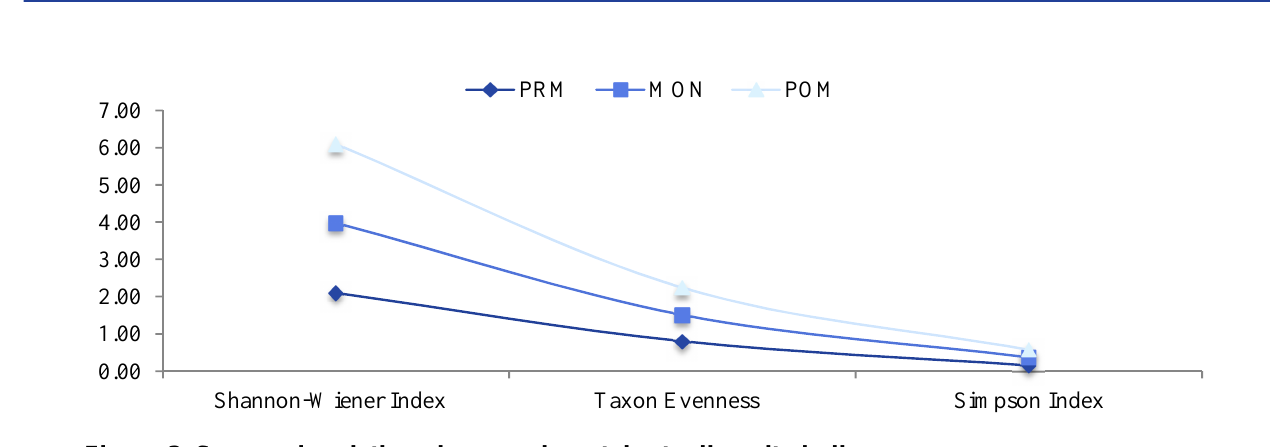
Figure 3. Seasonal variations in macroinvertebrate diversity indices PRM: Premonsoon; MON: Monsoon; POM: Postmonsoon